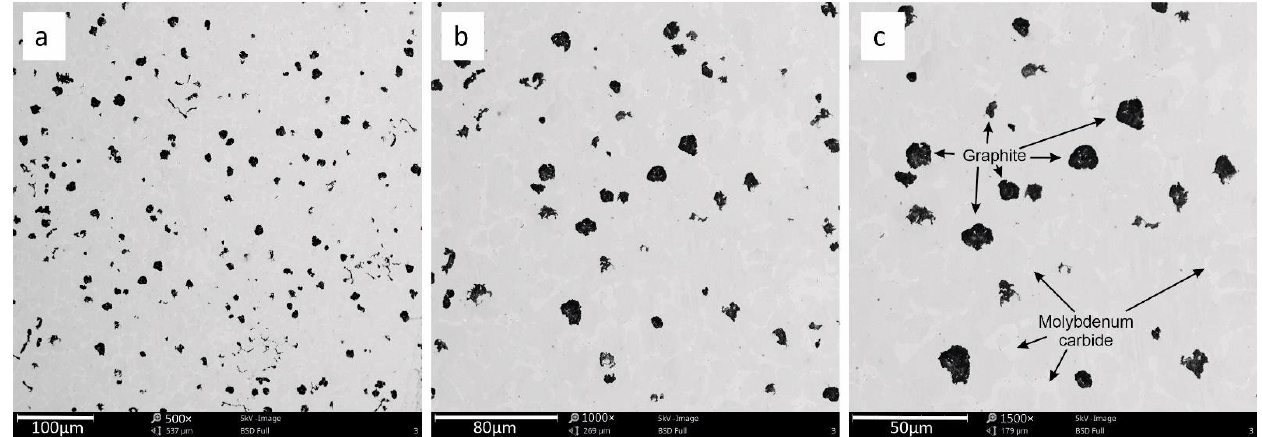
Figure 3. The cast iron microstructure for sample 3 with precipitation of graphite and molybdenum carbide. Magnification 500× ( a ), 1000× ( b ), 1500× ( c ).